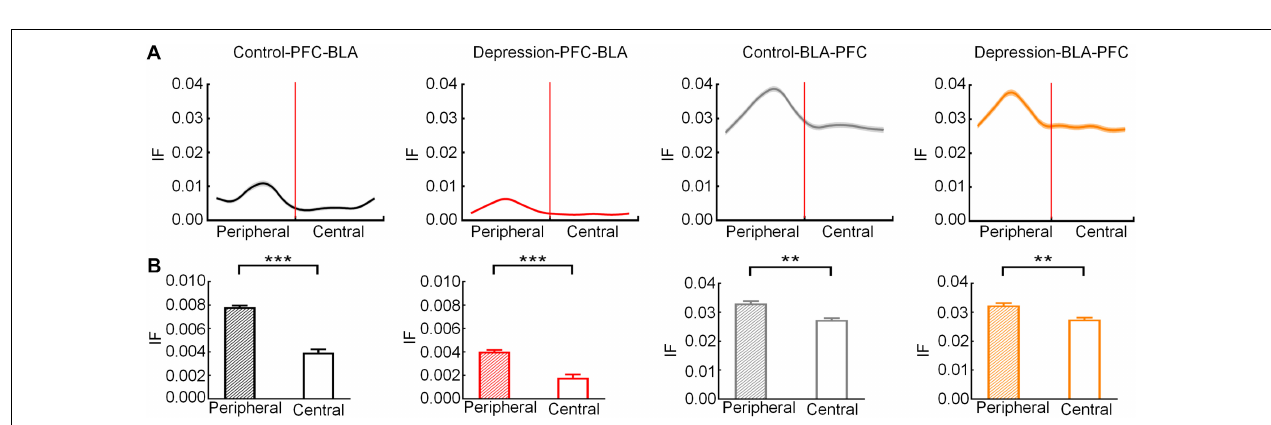
FIGURE 5 | Comparison of the average theta band DTF of the mPFC and BLA in exploratory behavior between the control and depression groups. (A) Comparison of the average theta DTF of the mPFC in the peripheral zone. (B) Comparison of the average theta band DTF of the mPFC in the central zone. (C) Comparison of the average theta band DTF of the mPFC from the peripheral to the central zone. (D) Comparison of the average theta band DTF of the BLA in the peripheral zone. (E) Comparison of the average theta band DTF of the BLA in the central zone. (F) Comparison of the average theta band DTF of the BLA from the peripheral to the central zone. Error bars indicate SEM. Independent sample t -test, ** p < 0.01, *** p < 0.001.